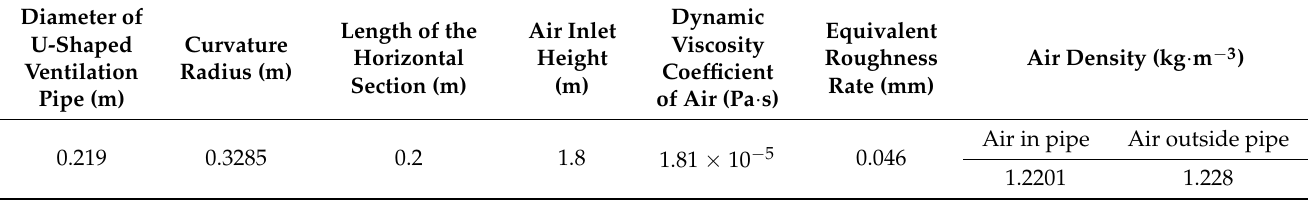
Table 1. Calculated